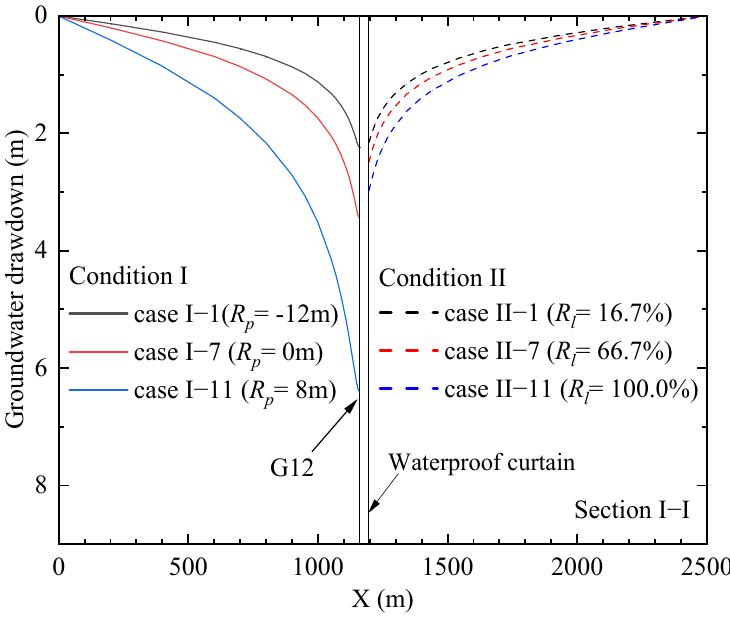
Figure 9. Groundwater drawdown outside the pit under different calculation cases on section I-I. Table 3. Simulated cases considering different R p and L values.